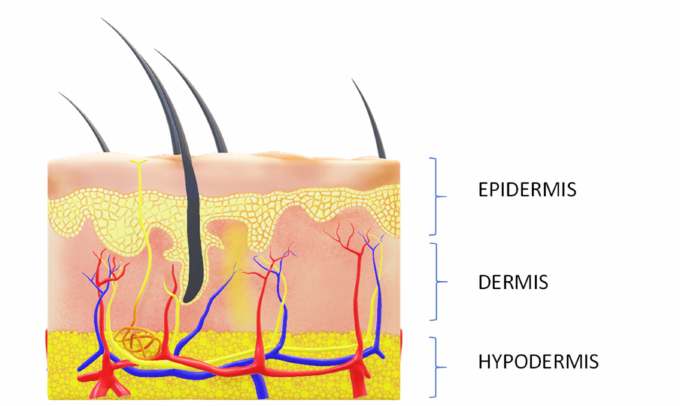
Figure 1. Diagram of the